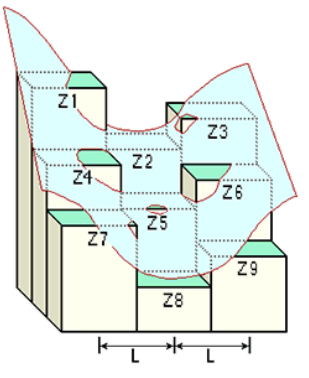
Figure 14. Curvature values Diagram (ArcGIS Version 10.3; ESRI, 2016)